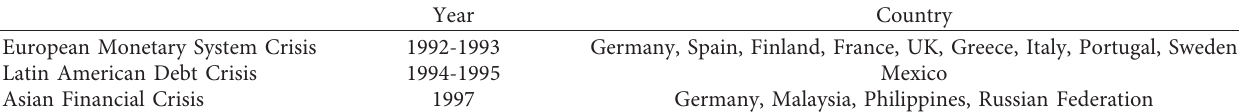
Table 6: Countries involved in BOP crisis.